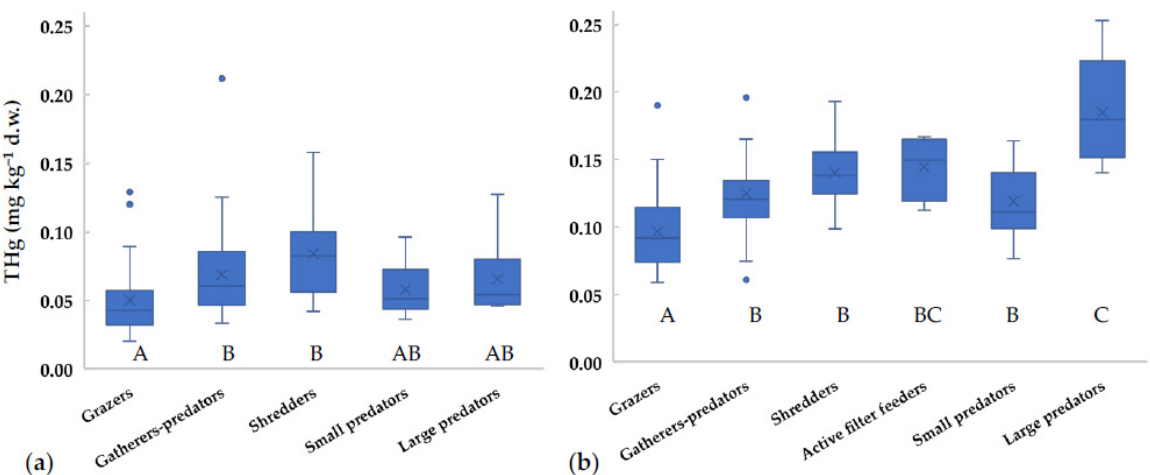
Figure 2. Concentrations of total mercury in different Functional Feeding Groups (FFGs) collected in the Toce River ( a ) upstream and ( b ) downstream of the industrial site between 2014 and 2018. x = mean value, horizontal line in boxes = median value, box = 25th–75th percentiles, whiskers = min-max range, points = outliers. Uppercase letters represent significant differences between FFGs according to ANOVA test followed by Tukey post-hoc ( p <